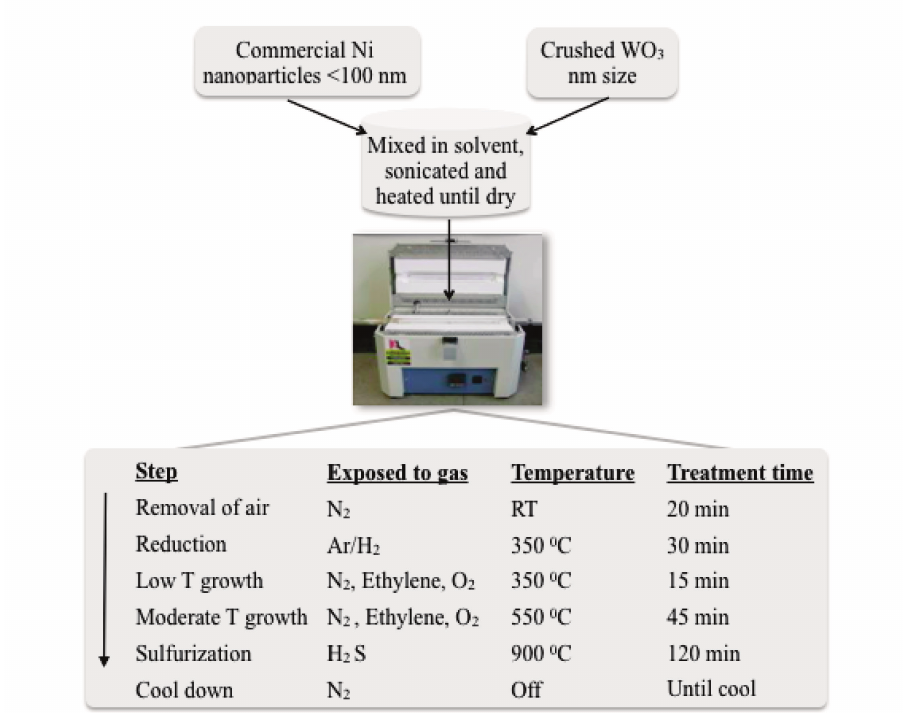
preparation steps. Ni nanoparticles and WO Figure 10. CNF/IF-WS 2 combined in solution using sonication in ethanol, dried and placed in a crucible inside a quartz tube of a tubular furnace. The mixture was then exposed to diverse environments and thermal treatments to generate Carbon Nanofiber/tungsten disulfide hybrids (CNF/IF-WS 2